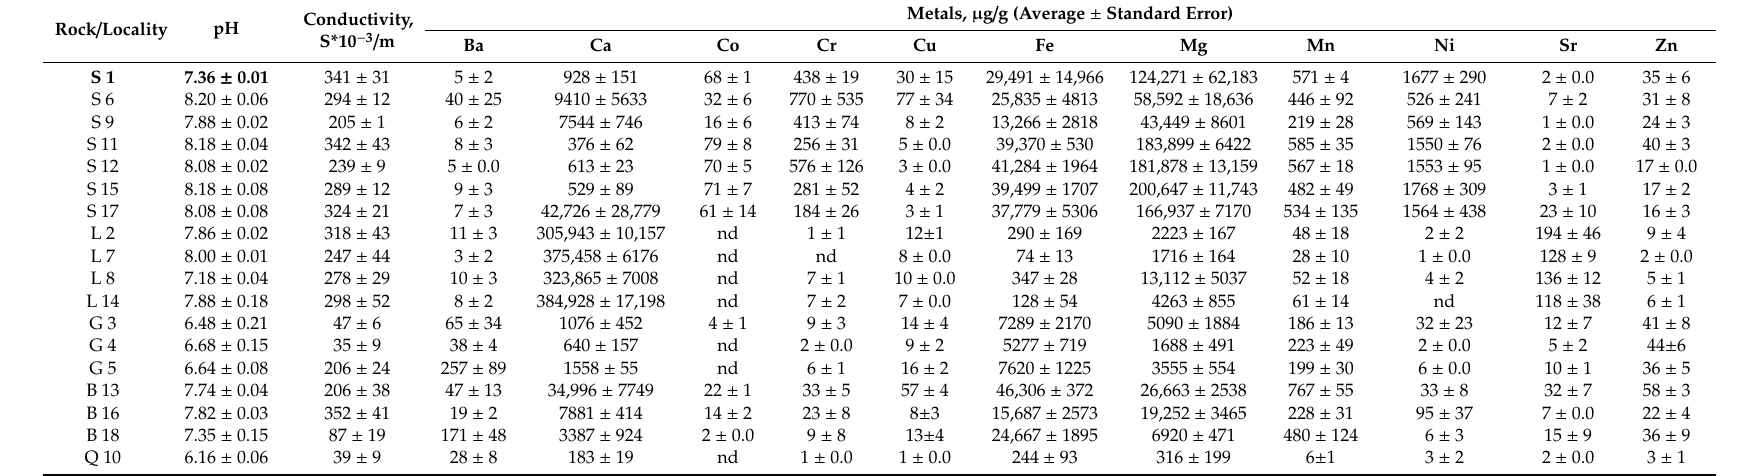
Table 4. Chemistry of rocks in the studied